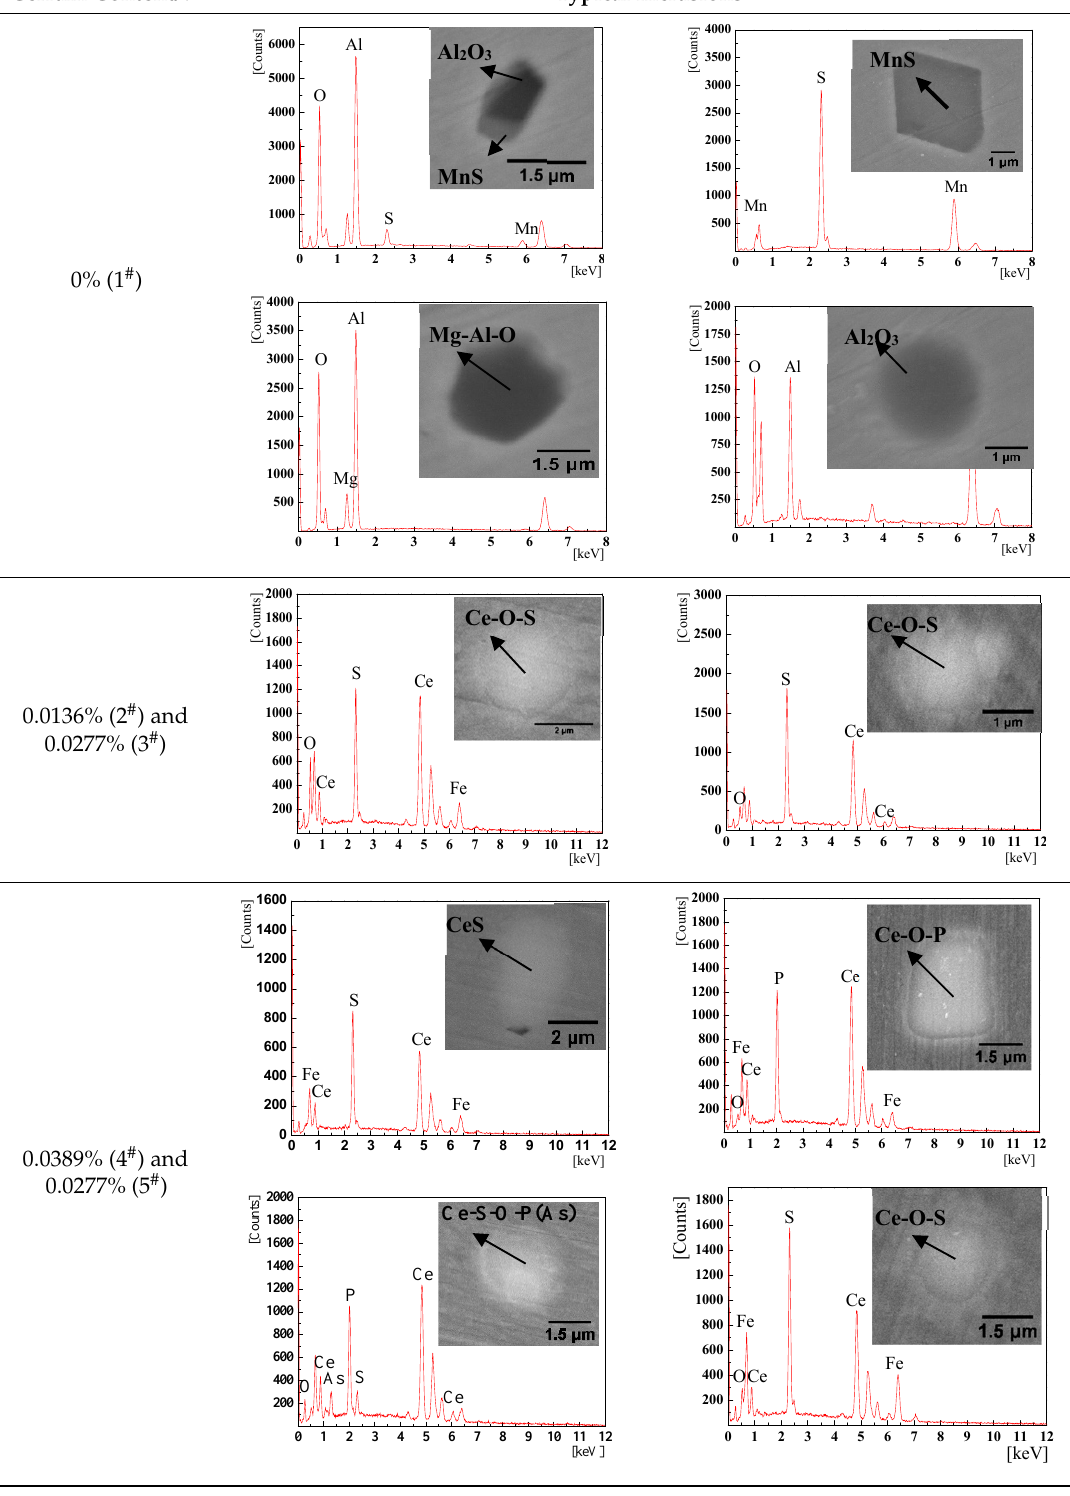
Figure 4. The morphology and composition of the typical Ce–O–P homogeneous composite inclusion. Figure 5. The morphology and composition of the typical Ce–O–P stratified composite inclusion.